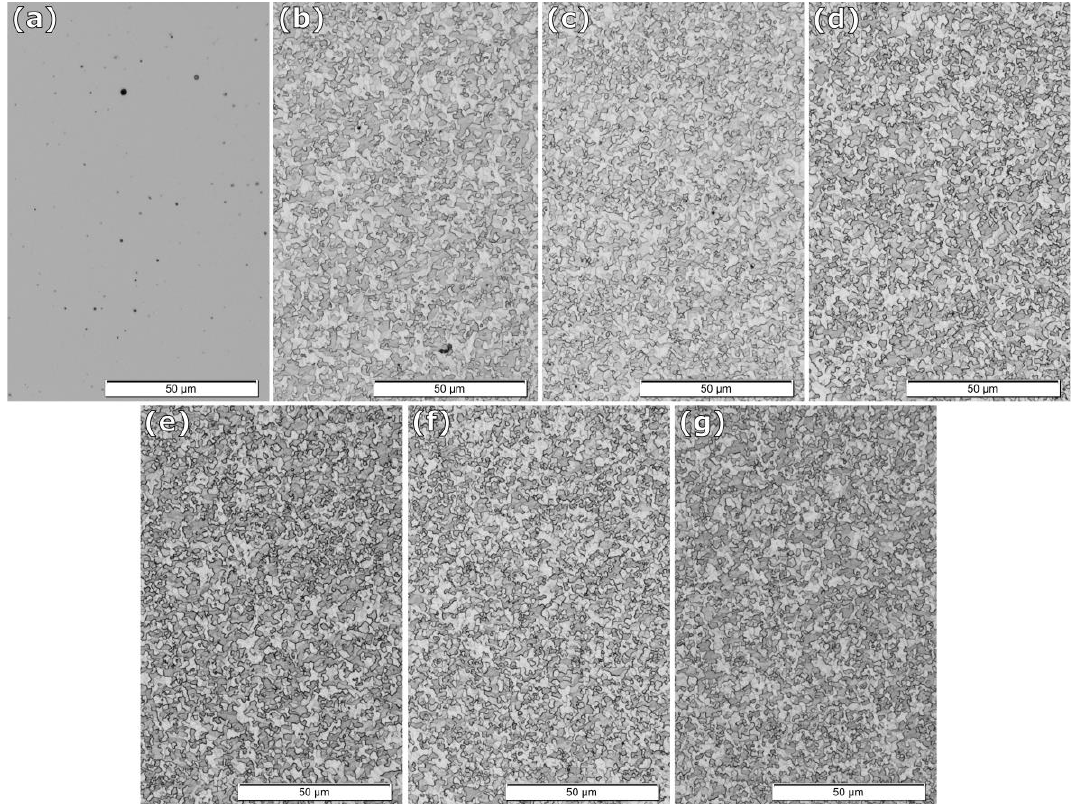
Figure 2. Optical microscopy images of the surface of V 2 O 5 thin films annealed at various tempera- tures: ( a ) as deposited, ( b ) 423 K, ( c ) 473 K, ( d ) 523 K, ( e ) 573 K, ( f ) 623 K and ( g ) 673 K.